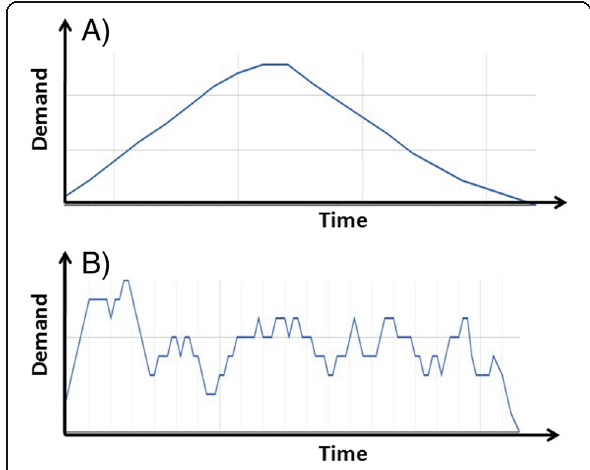
Fig. 5 Typical experimental demand patterns: a Mediawiki/EC2 - Steady rise and fall of demand; b OrangeHRM/Microsoft Azure - Series of step-wise increases and decreases of